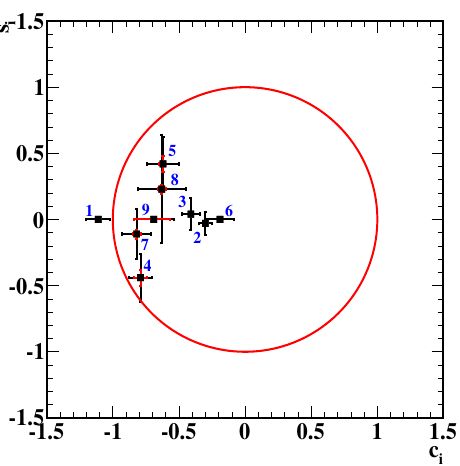
Figure 11 . c i and s i values in each bin. The black and red error bars represent statistical and systematic uncertainties, respectively.